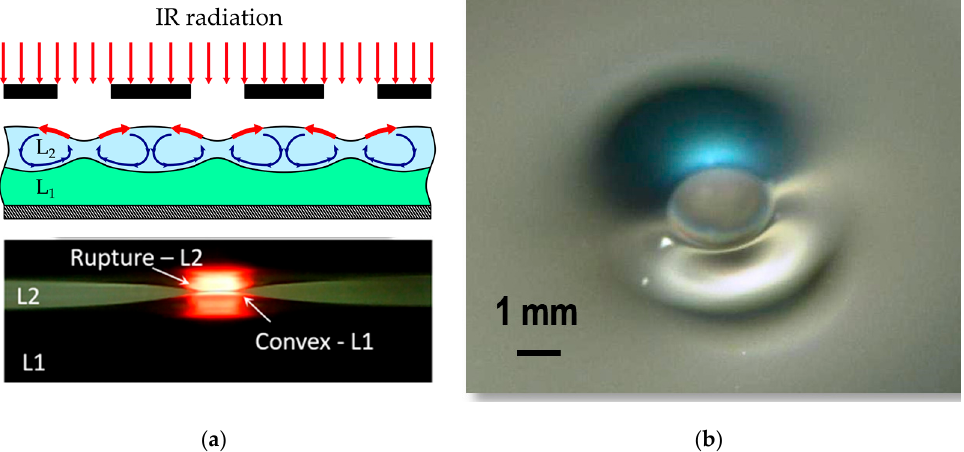
Figure 5. The light-induced thermocapillary effect in bilayer systems with a free liquid–air interface of an upper layer. ( a ) Illustration of interfacial deformations generated by a spatially modulated radiation in the light-absorbing upper layer (at the top). A side-view not to scale image of the thermocapillary deformation of the liquid–liquid (L1-L2) interface and the rupture of the upper layer caused by a single laser beam according to experimental conditions in [34] (at the bottom); ( b ) a top-view of the thermocapillary rupture of the bilayer system.